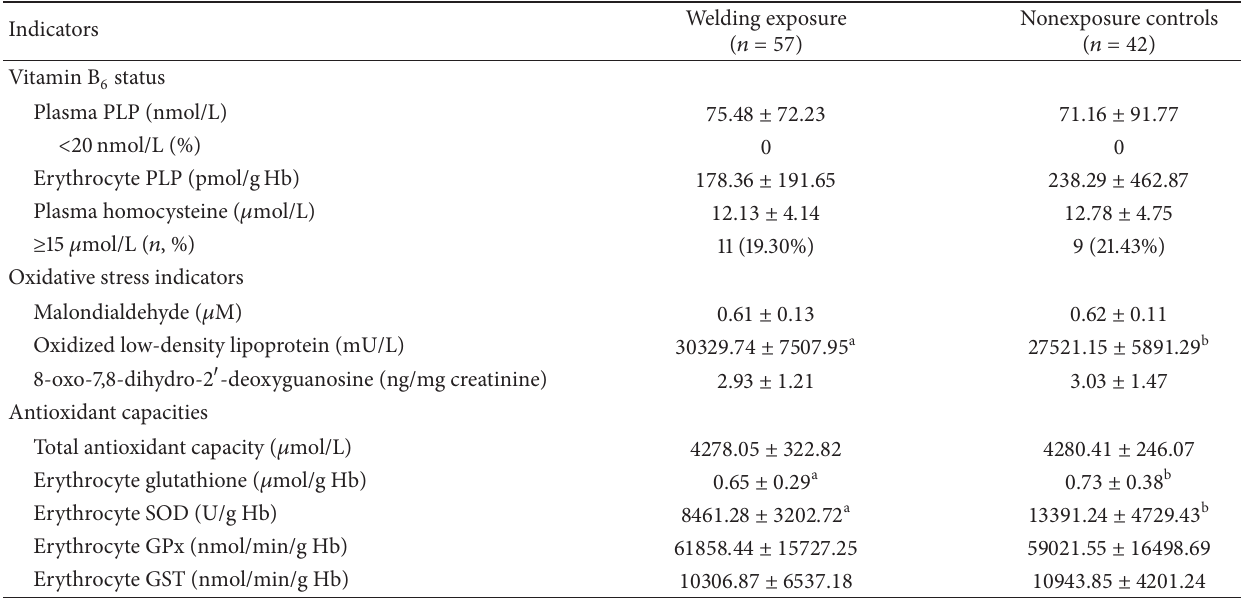
Table 2: Vitamin B status, oxidative stress indicators, glutathione, and antioxidant 6